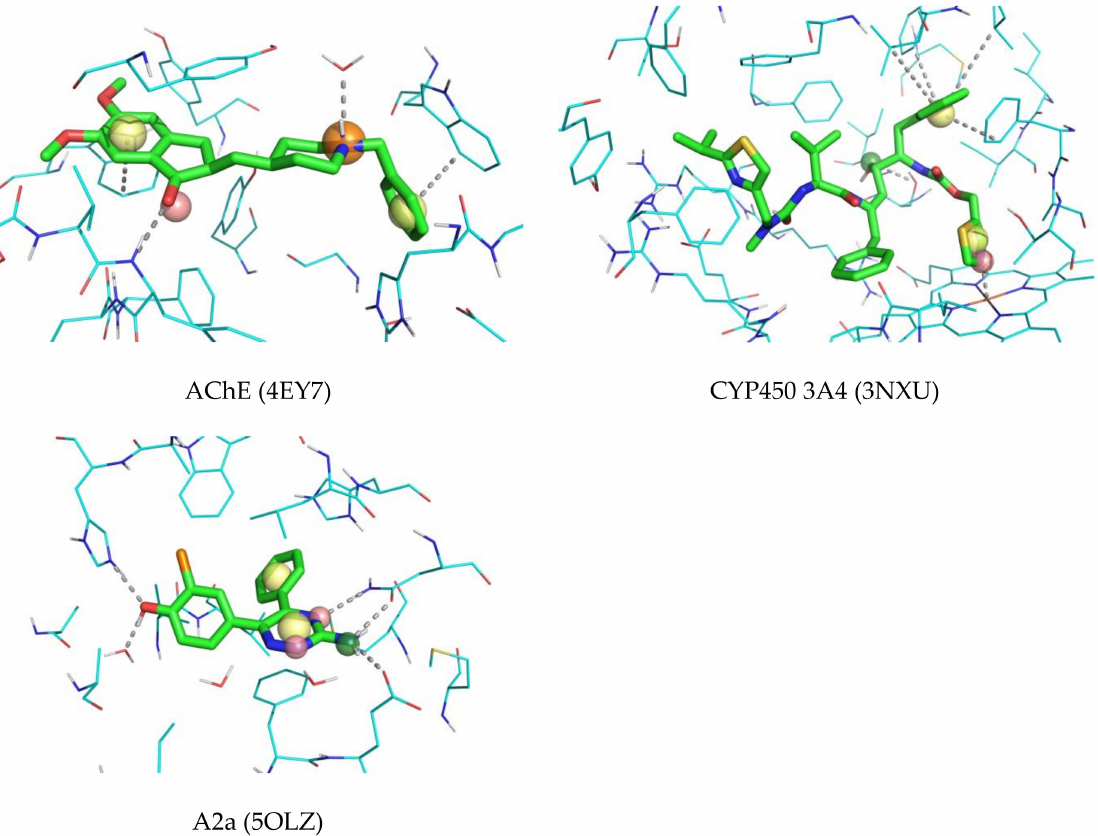
Figure 10. Examples of compounds matching corresponding 3D pharmacophore models developed in this study. Red spheres denote H-bond acceptors, yellow spheres—hydrophobic/aromatic features, orange spheres—H-bond donor and positively charged centers, green sphere—H-bond donor and H-bond acceptor